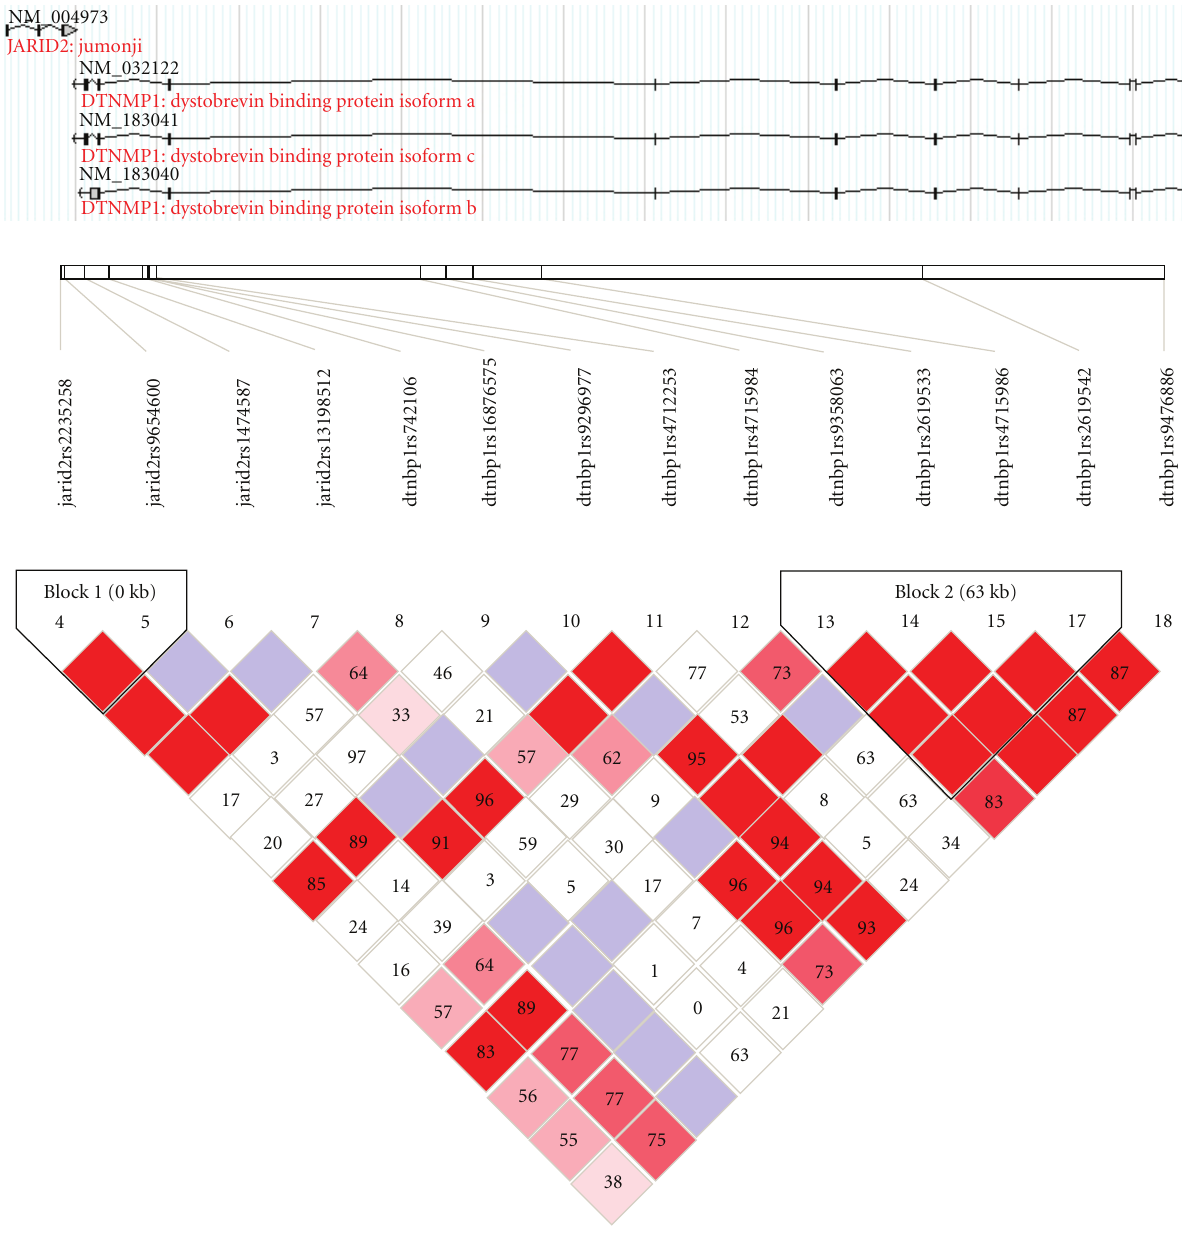
Figure 1: Linkage disequilibrium in JARID2 and DTNBP1 in a homogenous population in Shandong peninsula of China. The AT haplotype in JARID2 (block1) more in cases than in controls (Frequency = 0 . 667, Case control ratios = 108 . 0 : 68 . 0,125 . 6 : 48 . 4; X 2 = 4 . 622, P = . 0316), allelic and genotypic association also observed. This samples was from an isolated population with about 600 years history of immigration in the middle east of Shandong peninsular of